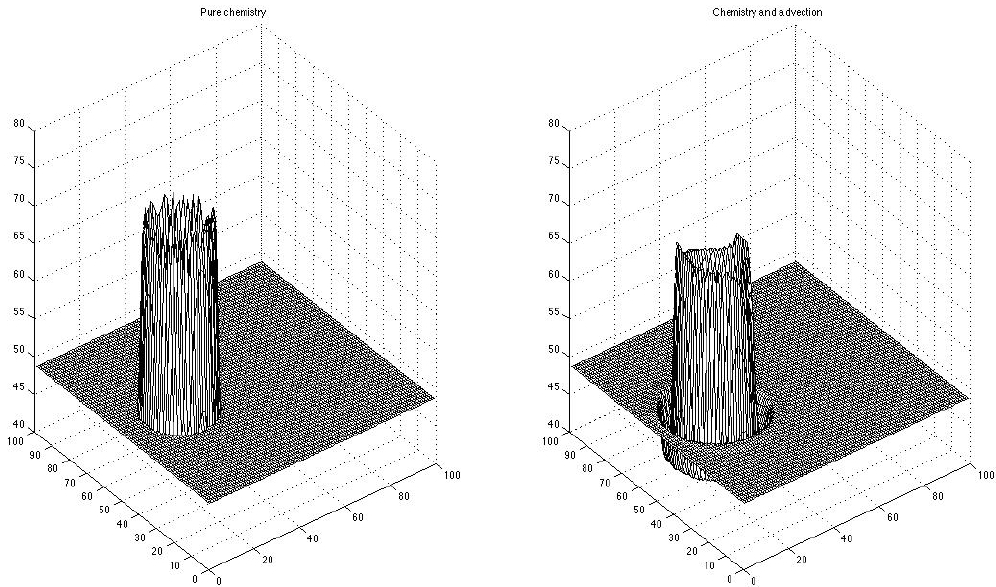
Fig. 7. Rotation test for LMCSL with filter using the rotating cone for O 3 with urban conditions and resolution 1 1, with 1t = 90s, 1x = 1 . 0, and C = 0 . 327. The results are given for pure chemistry (left) and combined chemistry and advection (right). The minimum and maximum values for the respective plots are: Left: minimum=48.55, maximum=64.58. Right: minimum=43.03,